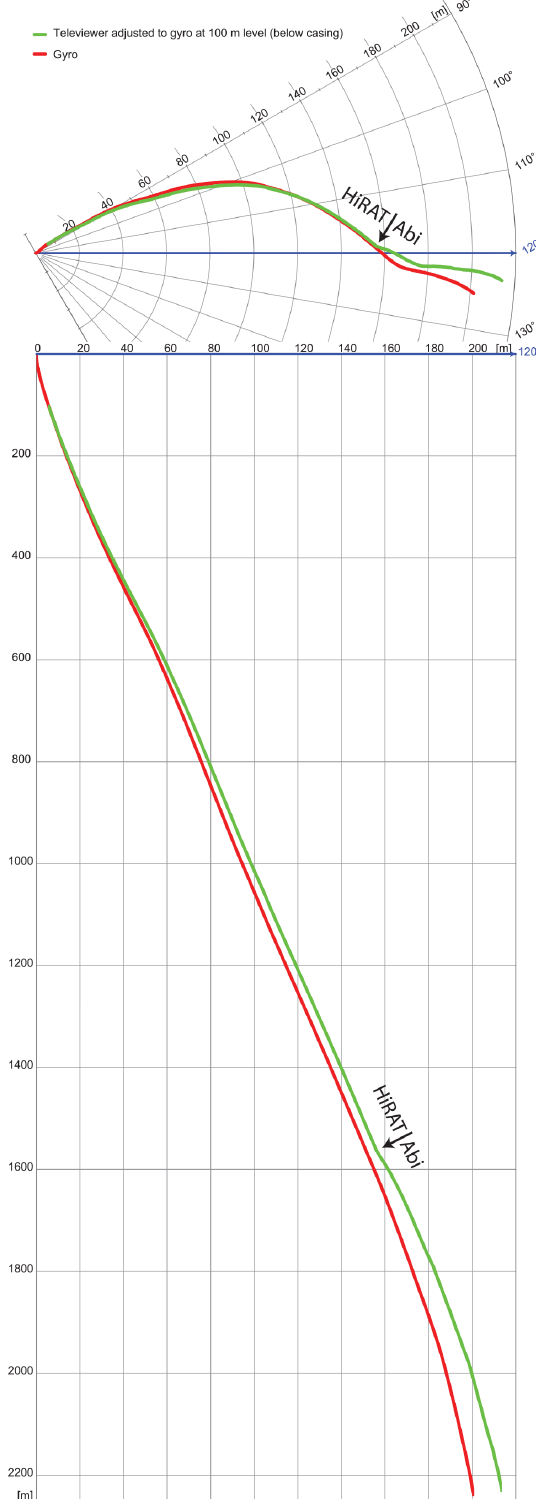
Figure 5. Borehole path of the COSC-2A borehole, based on surveys with a north-seeking gyro (red; REFLEX GYRO SPRINT-IQ™) and the orientation sensors of acoustic televiewers (green; derived from accelerometers and magnetometers). The televiewer data are spliced at 1570m, with data from the Robertson Geologging High-Resolution Acoustic Televiewer (HiRAT) above this depth and from the ALT Abi43 televiewer below this